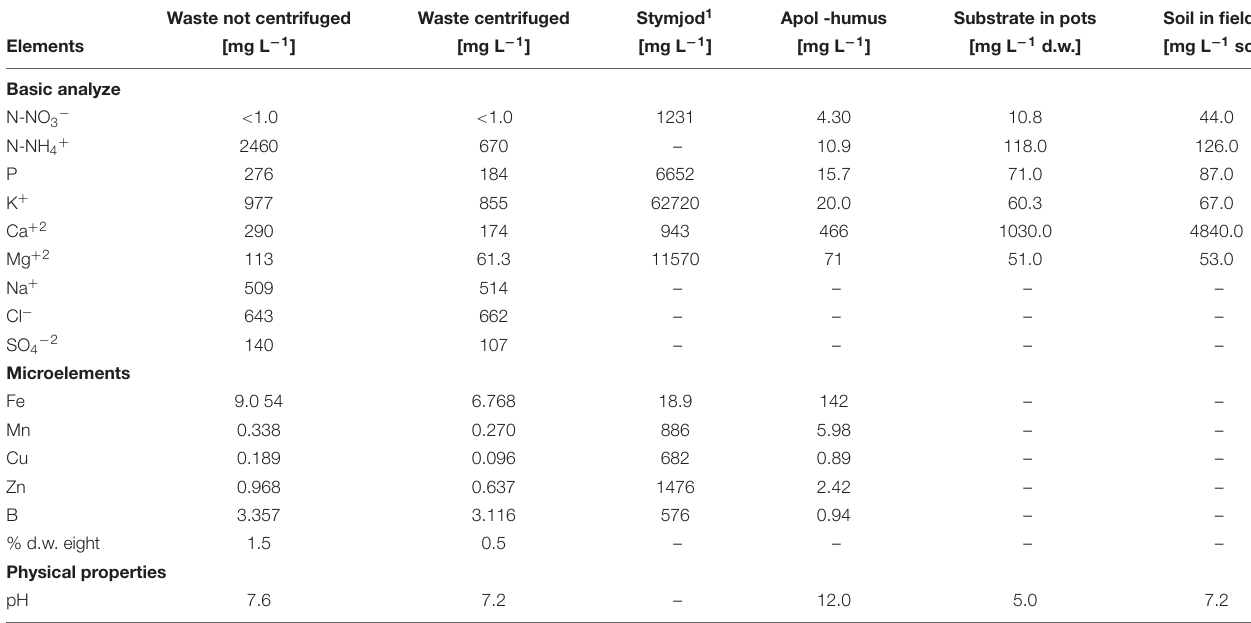
TABLE 1 | Content of macro- and micronutrients and physical properties of liquid non-centrifuged and centrifuged wastes from a biomass biodigestion to methane, Stymjod, Apol-humus, and peat substrate in 5-l pots and in podzolic soil in field. Waste not